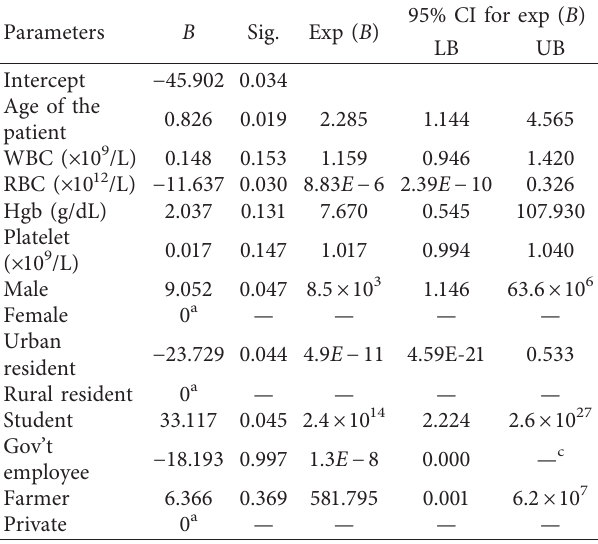
N � number and % � percentage. Table 3: Multinominal regression model of AML for patients who have abnormal hematological parameters in Jimma Medical Center from January 1, 2019, to April 30,